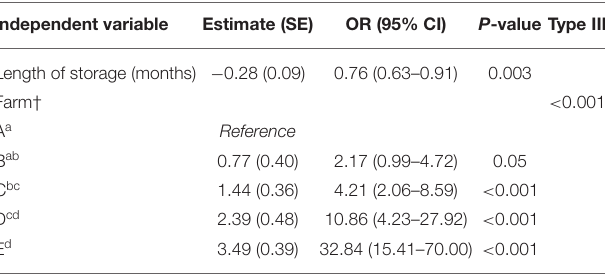
TABLE 5 | Odds of contamination ∧ in lab-pooled samples based on mixed logistic regression modelling. Independent variable Estimate (SE) OR (95% CI) P -value Type III